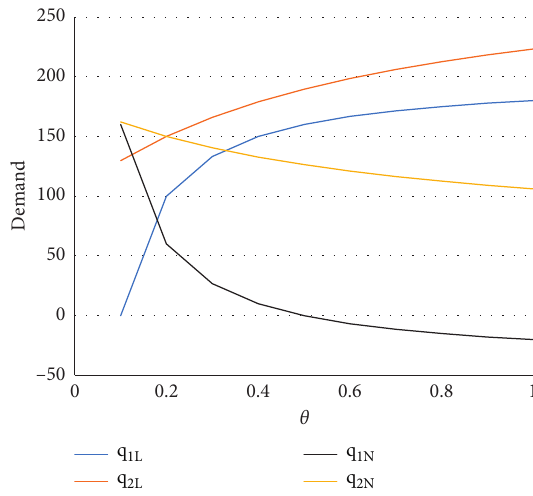
Figure 5: The influence of parameters θ on demand.